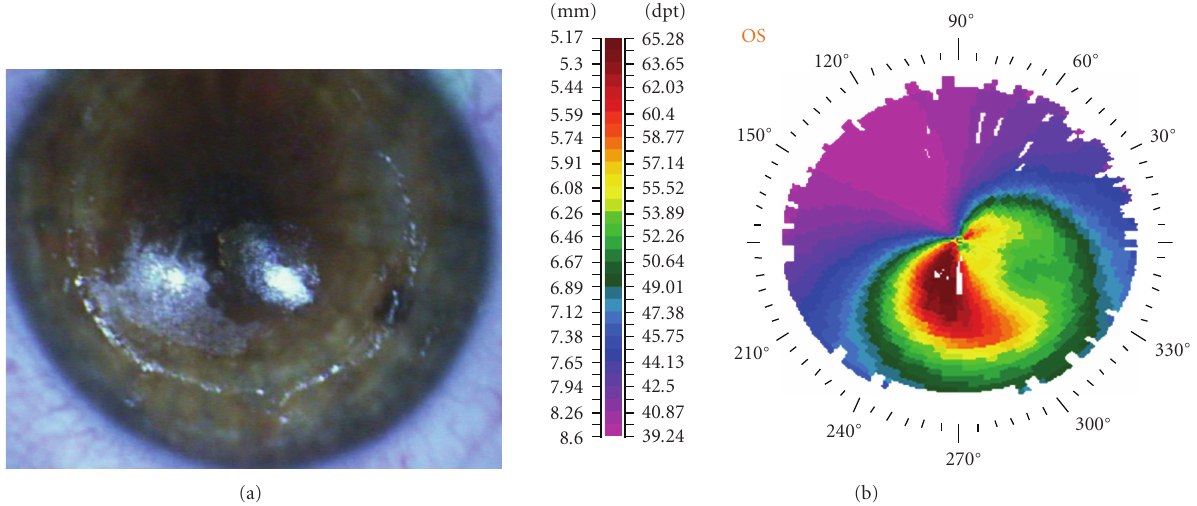
Figure 1: Intraoperative photography (a) showing the correlation between the ablated stroma (coarse surface) after transepithelial phototherapeutic keratectomy (t-PTK) and the preoperative corneal topography (b).